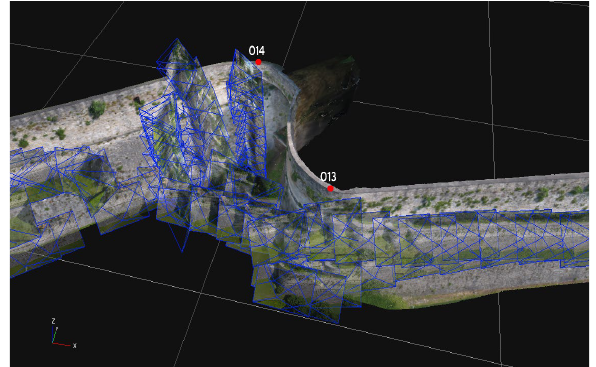
Figure 8. An example of UAV camera displacement for the embrasure of St. Michele bulwark.